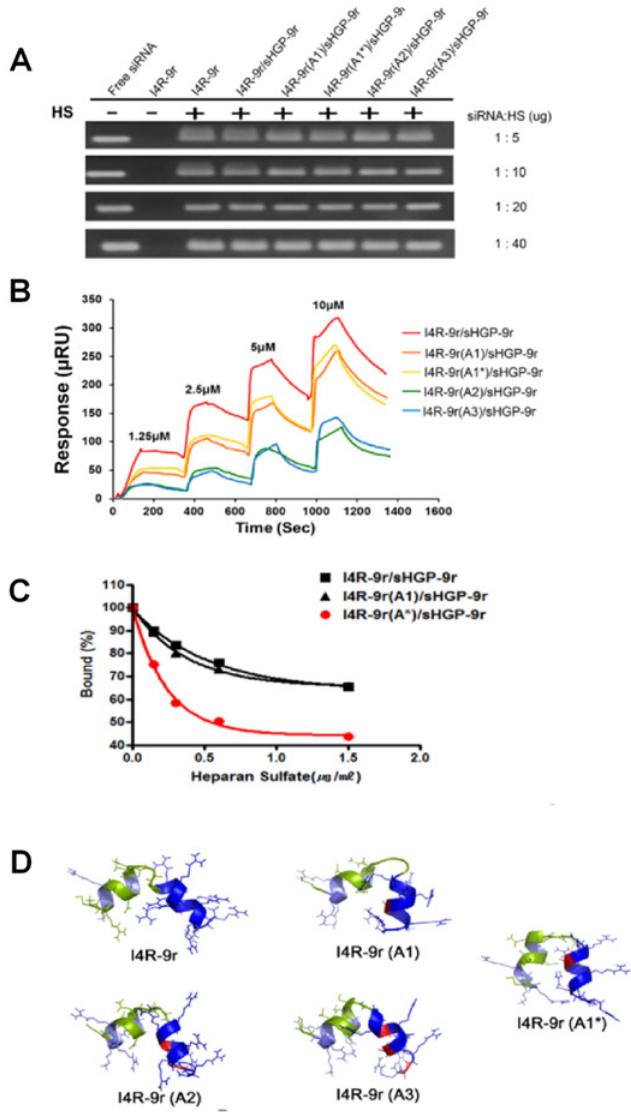
Fig 5. Dynamic interactions and structures of I4R-9r variant/siRNA nanocomplexes. (A) The released siRNA from nanocomplexes were examined upon addition of excess amount of Heparan sulfate (w:w of siRNA to Heparin sulfate as 1:5 – 1:40)using gel retardation assay. (B) The kinetics of association of siRNA with I4R-9r variant/sHGP-9r using SPR analysis. Increasing concentrations of I4R-9r variant/sHGP-9r peptides were injected to associate with 5`-biotinylated siRNA on the streptavidin chip. (C) The kinetics of disassociation of siRNA with I4R-9r variant/sHGP-9r using SPR analysis. After association of 5`-biotinylated siRNA with I4R-9r variant/sHGP-9r (2.5 μ M) up to saturation different concentrations of heparan sulfate were injected to quantitate siRNA dissociation. The dissociation kinetics was analyzed using the Graph Prism 5.0. (D) The structures of I4R-9r variant were analyzed and compared by 3D modeling method (PEPFOLD); I4R peptide (green), Arginine of 9r (blue), Alanine